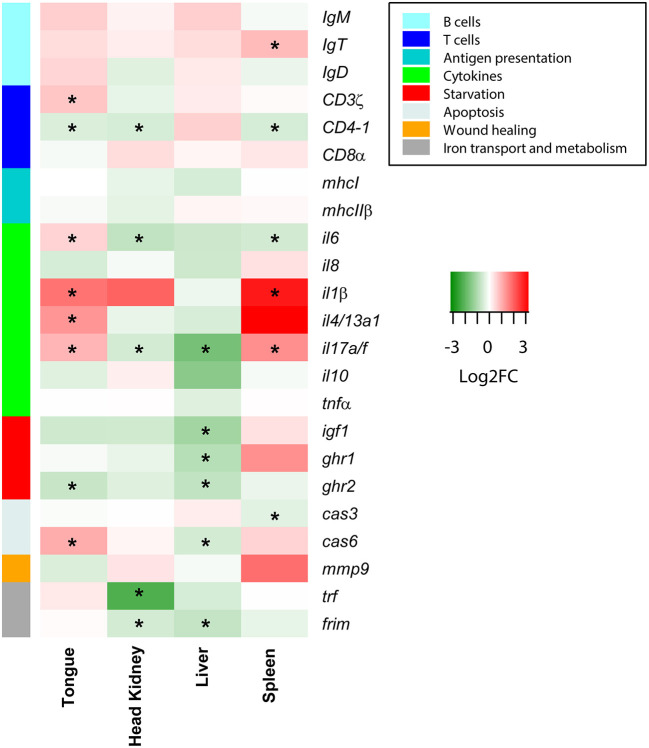
Heatmap depicting the PCR-array results of Dicentrarchus labrax samples from four organs. Red and green represent upregulated and downregulated genes, respectively, in Ceratothoa-infected fish relative to the uninfected controls. The color scale represents the Log2 fold change (Log2FC). Different colors on the left bar indicate the different pathways with which each gene was related. Asterisks represent statistically significant differences in the comparison of n = 10 infected and n = 10 control fish.